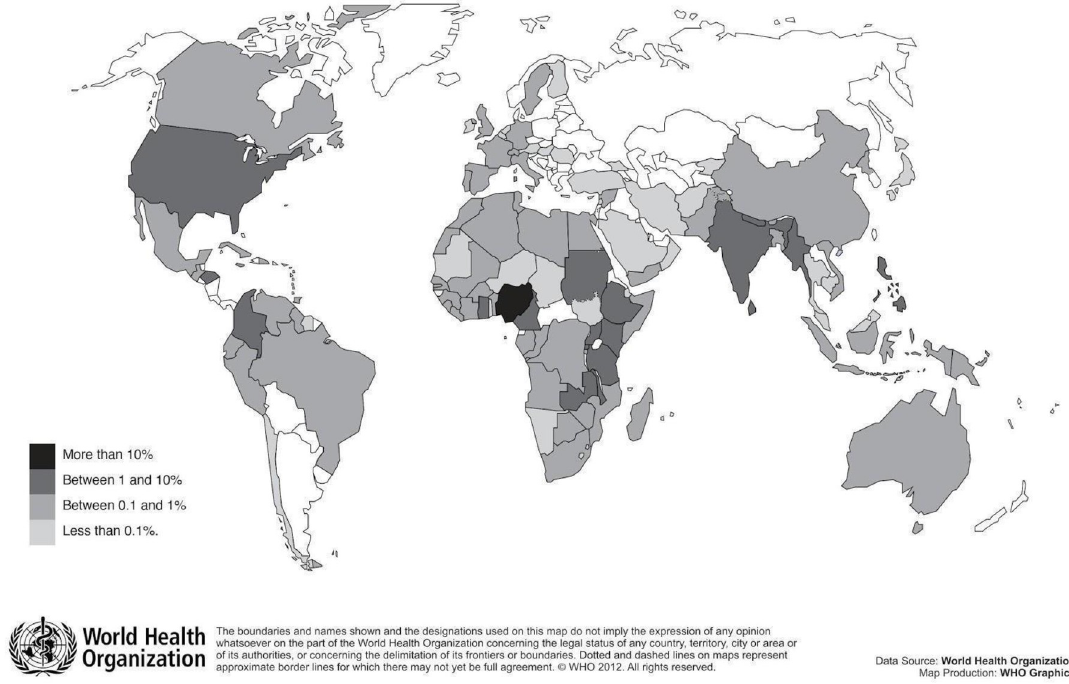
Fig 1. Represented countries of MOOC